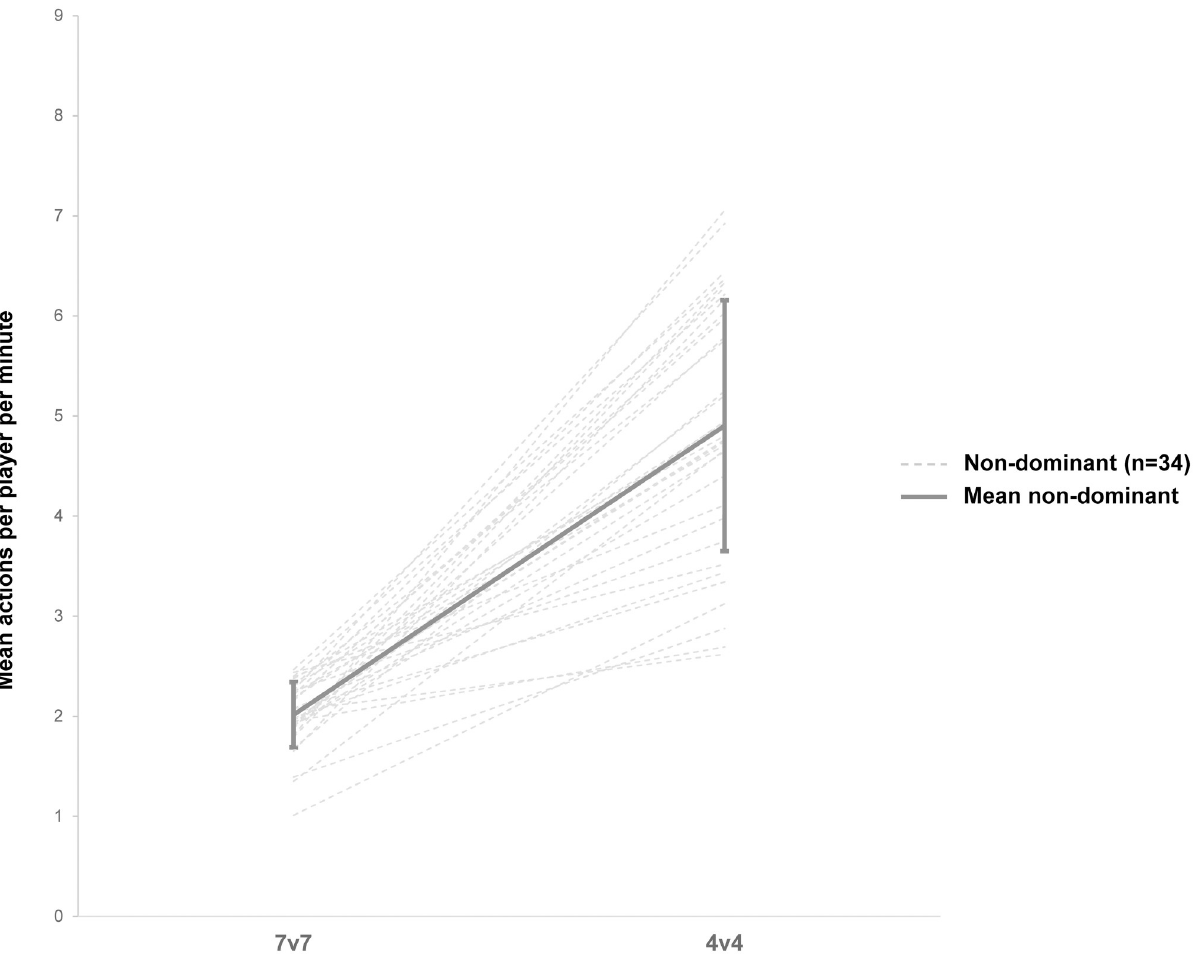
Fig 1. Number of actions per player per minute for dominant (n = 34) players in 7v7 compared to 4v4 match format.